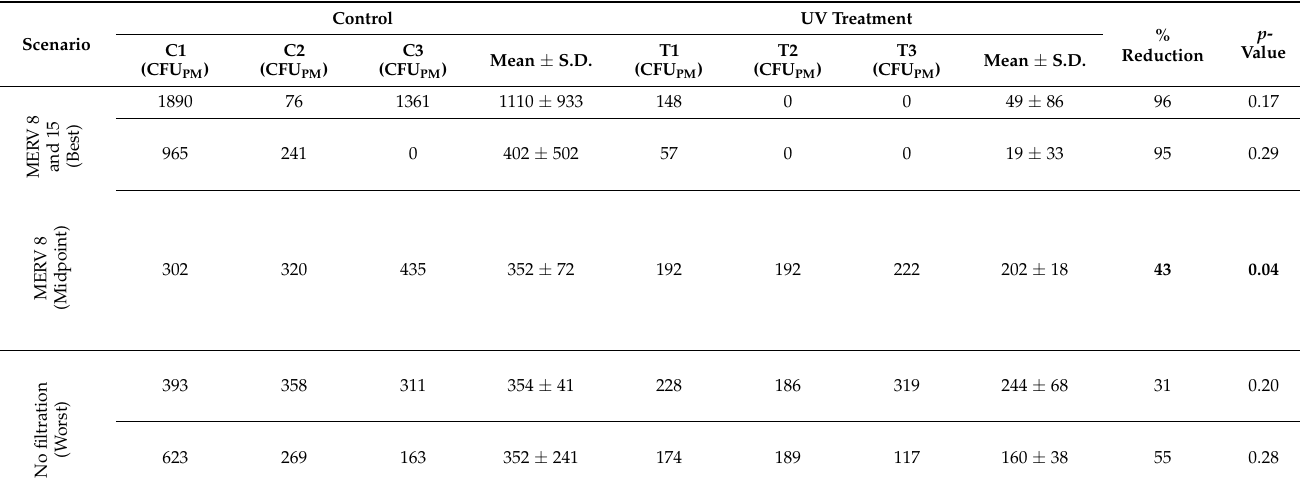
Table 5. CFU removal performance of UV-A photocatalysis (Treatment II) in mitigating airborne pathogens. Comparison of CFU D (CFU · m − 3 ) normalized by the total PM concentration ( µ g · m − 3 ) before and after UV-A photocatalysis (CFU PM , CFU · µ g − 1 ) and resulting percent reduction. Bold signifies statistical